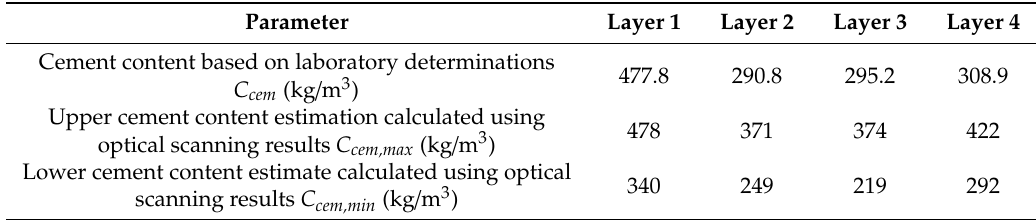
Table 7. Comparison of results (cement